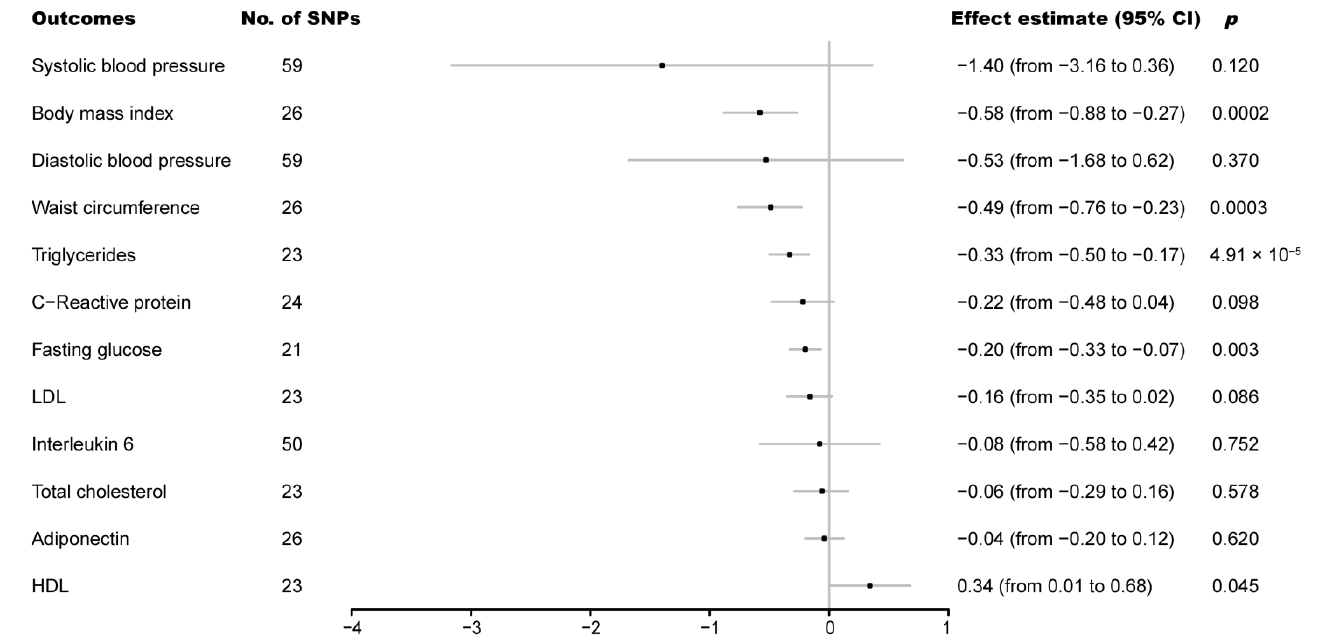
Figure 3. Associations of genetically predicted cheese intake with cardiovascular biomarkers. CI, confidence interval; HDL, high-density lipoprotein; LDL, low-density lipoprotein; SNP, single- nucleotide polymorphism.